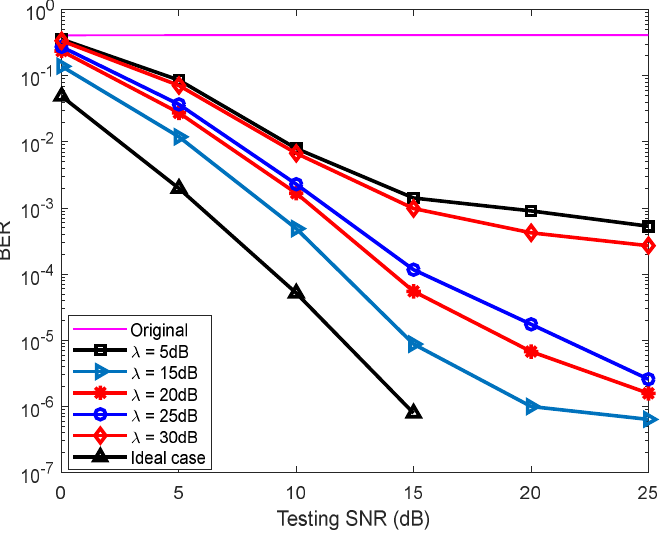
Figure 6. BER performance comparison of the proposed scheme under the LOS case.